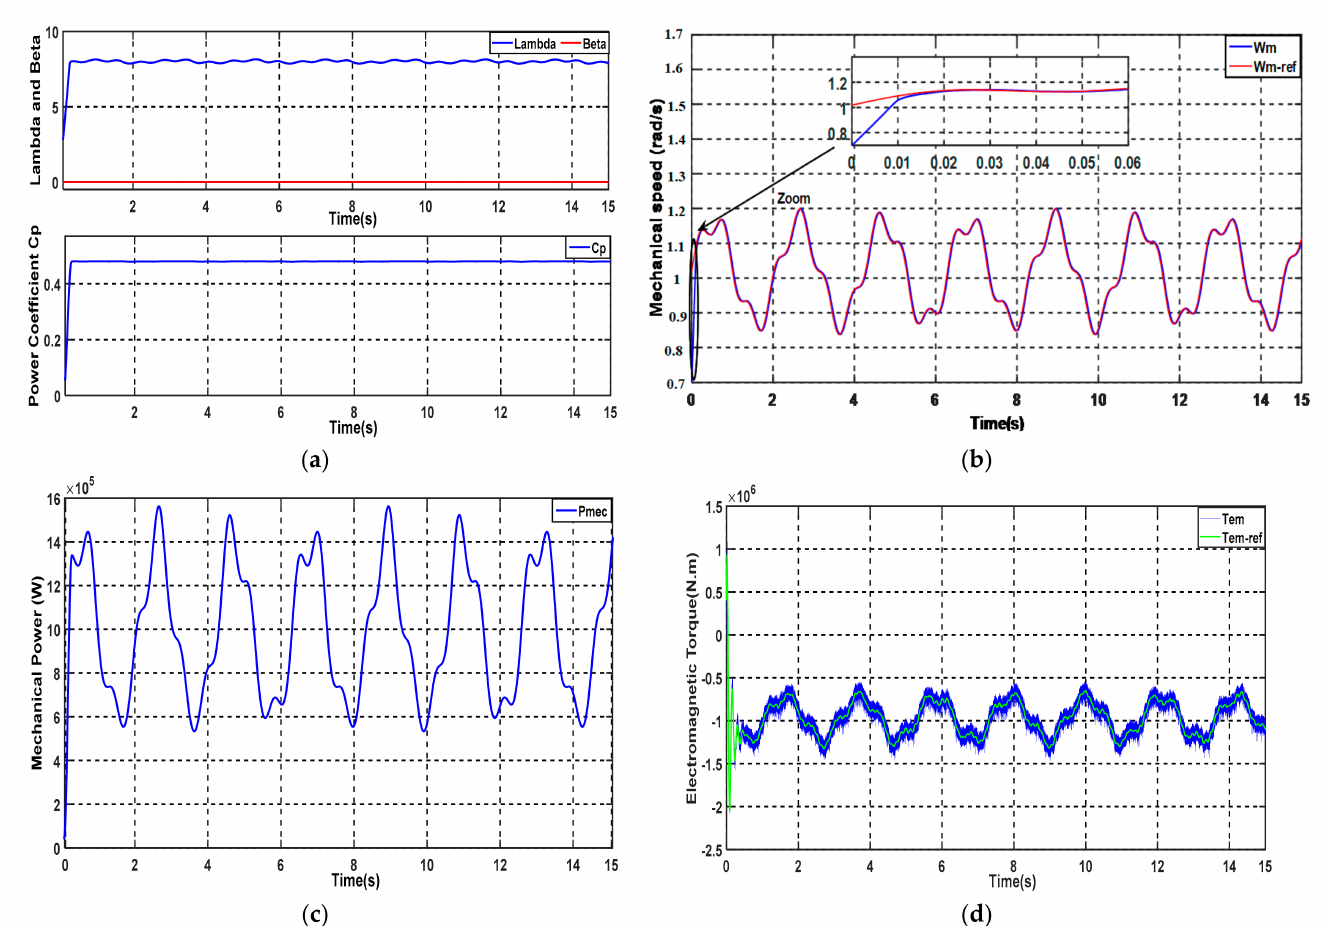
Figure 7. Performance of the system using the MPPT strategy: ( a ) tip speed ratio λ (lambda), Beta β and power coefficient (Cp), ( b ) mechanical speed ( W mec ) of the PMSG, ( c ) mechanical power ( P mec ), and ( d ) electromagnetic torque ( T em